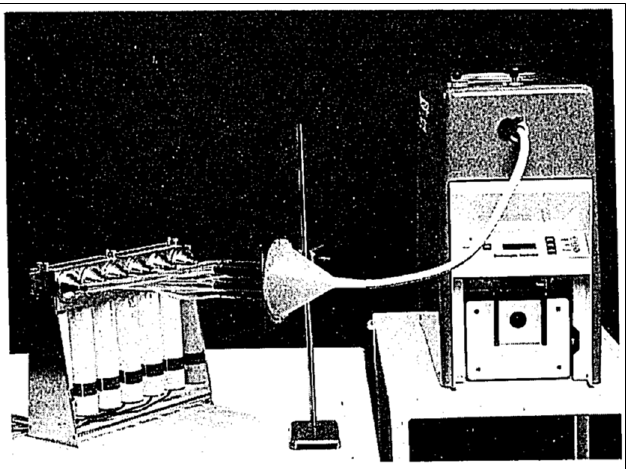
Figure 7. Photograph of a parallel di ff usion ba tt ery connected to a Technegas generator. Reprinted/adapted with permission from Ref. [17]. 1989, Wolters Kluwer Health, Inc.